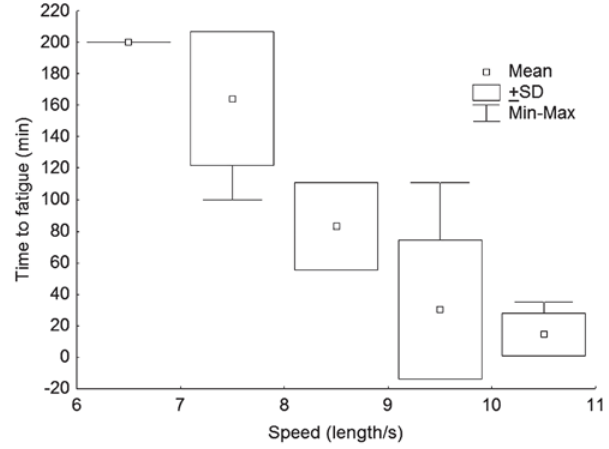
Fig. 6. Mean (± standard deviation – SD; minimum – Min; and Maximum – Max) values of time to fatigue (min) per speed class (lengths/s) for piau Leporinus